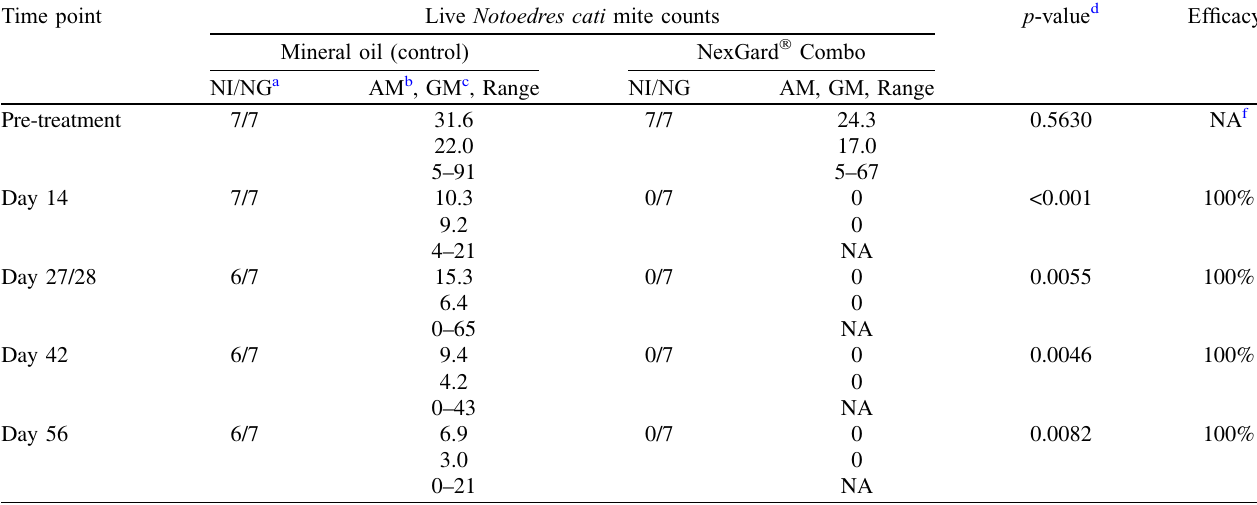
Table 2. Live Notoedres cati mite counts in cats treated topically once (Day 0) either with mineral oil (placebo control) or NexGard (cid:1) Combo, and percentage ef fi cacy of NexGard (cid:1) Combo treatment over eight weeks after treatment. Time point